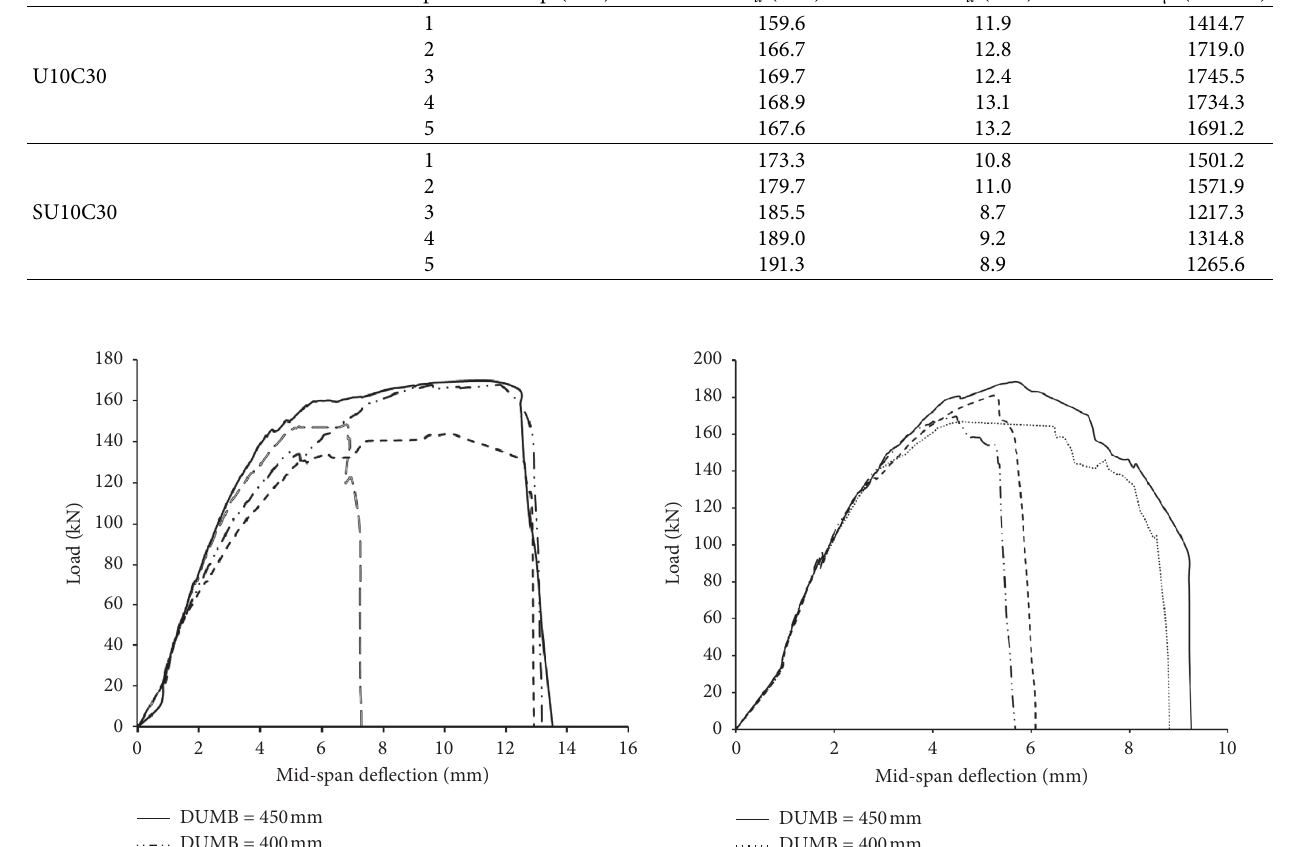
Table 6: Ultimate load, ultimate deflection, and MOTvalue of beams U10C30 and SU10C30 strengthened by the different thicknesses of the U-shaped steel strip. Beam Thickness of U-shaped steel strip (mm)